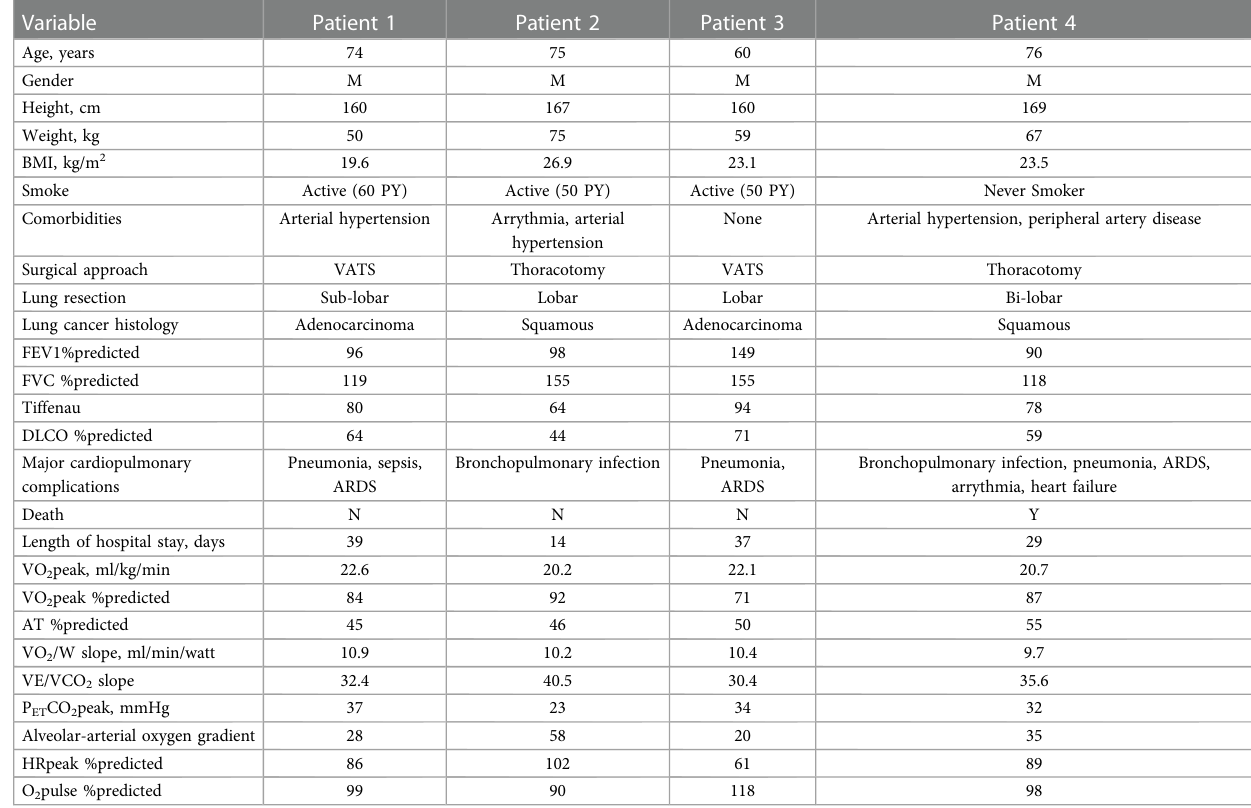
TABLE 2 Characteristics of complicated patients within CPET group.